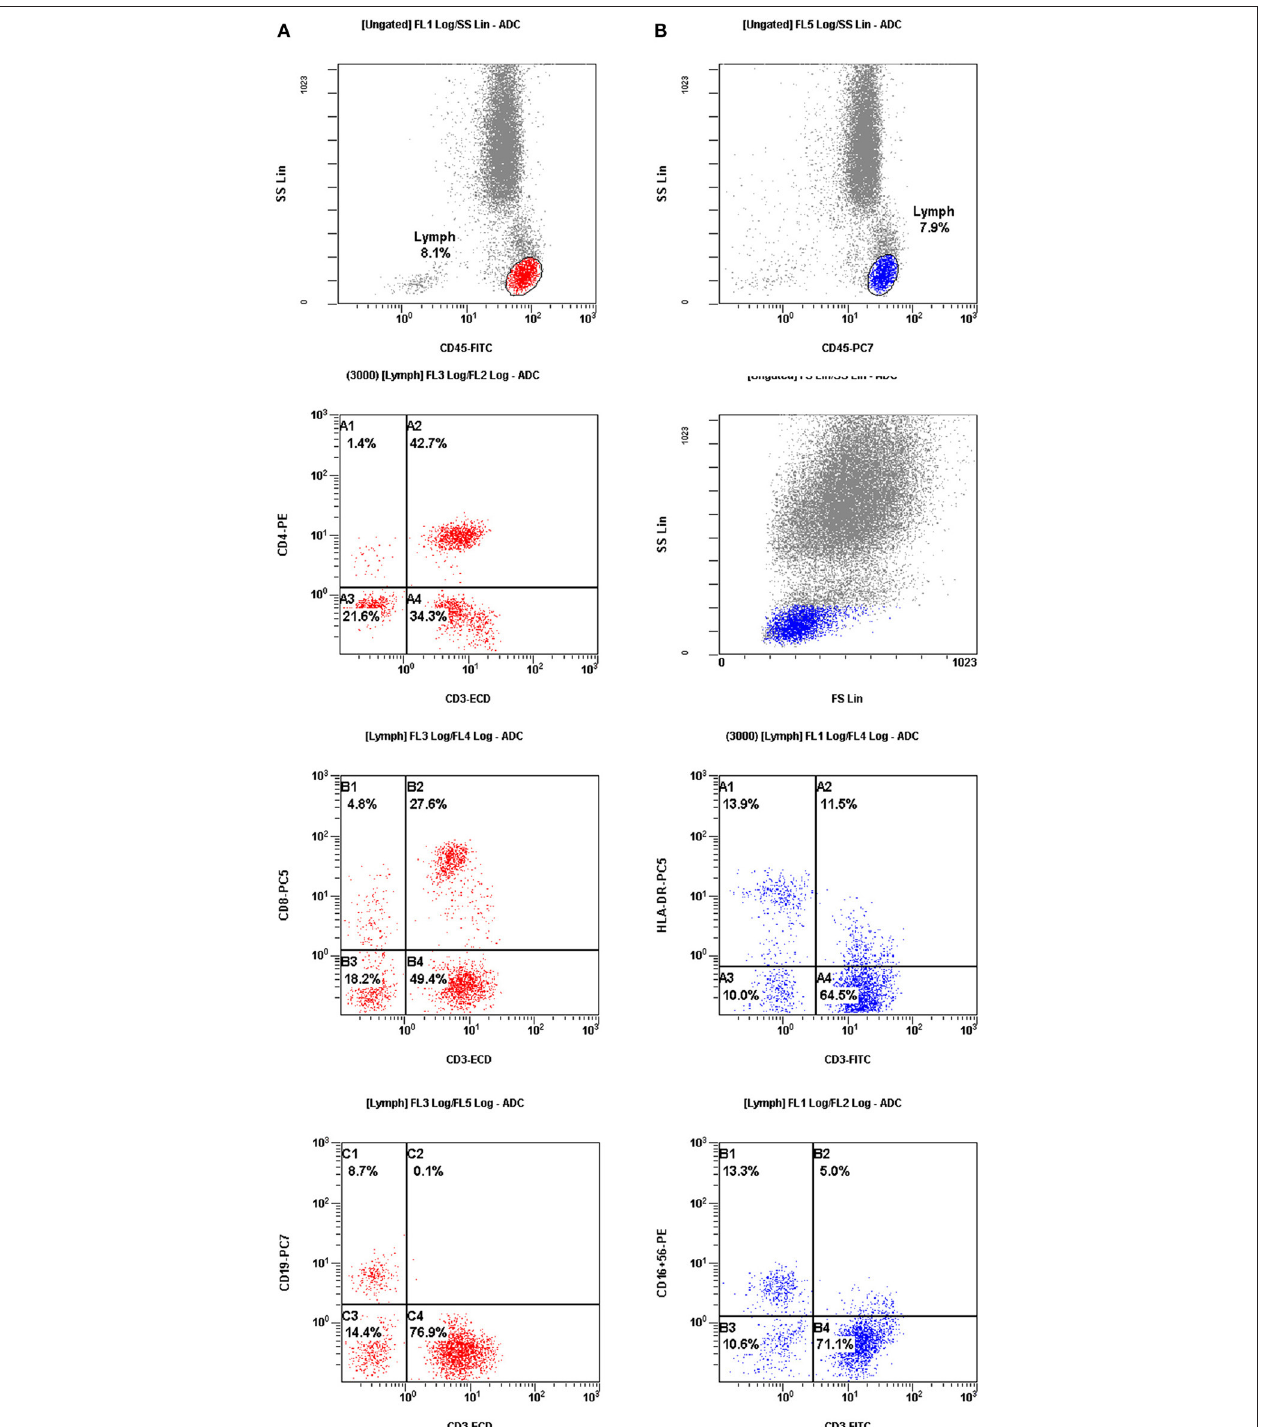
FIGURE 2 | The results were presented as a percentage of total lymphocytes. Cell sorting for assessment of the mononuclear cell profiles in peripheral blood from patients with repeated implantation failure (RIF). (A) (red color) Mononuclear cells were gated by fluorescence intensity of CD45 vs. side light scatter (SSL). The T cells (CD3 + , C4) and B cells (CD19 + , C1) were gated by fluorescence intensity of CD3 vs. CD19. The helper T cells (CD3 + CD4 + , A2) were analyzed for their expression of CD3 and CD4. The suppressor T cells (CD3 + CD8 + , B2) were gated by fluorescence intensity of CD3 vs. CD8. (B) (blue color) Activated T cells (CD3 + HLA-DR + , A2) were analyzed by the expression of CD3 and HLA-DR. CD56 + CD16 + NK cells (CD3 − CD56 + CD16 + , B1) were gated by fluorescence intensity of CD3 versus CD16 + CD56 + .